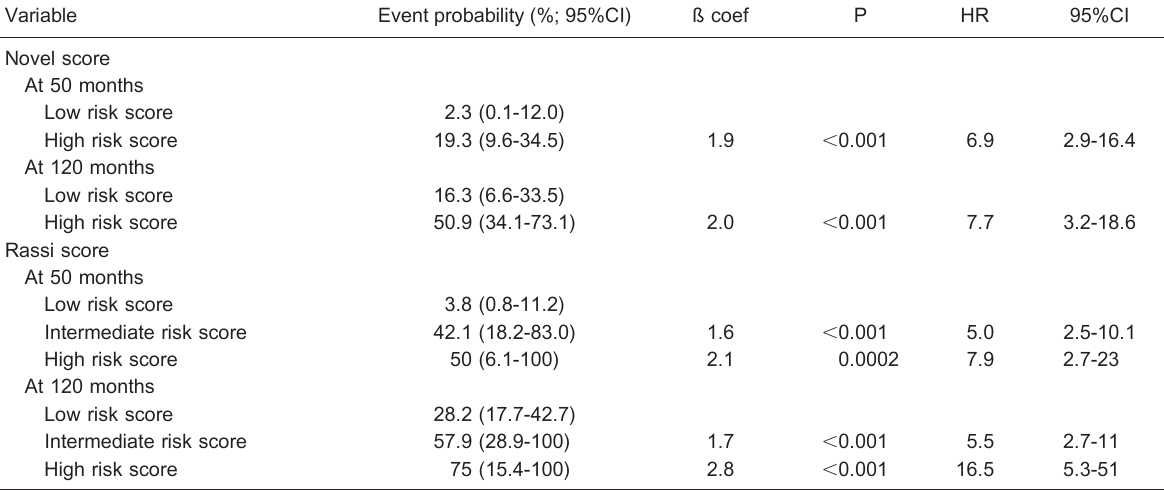
Table 3. Comparison of prognostic value of the novel score vs Rassi score for primary (composite) endpoint according to follow-up time. Variable Event probability (%; 95%CI) ß coef Novel score At 50 months Low risk score